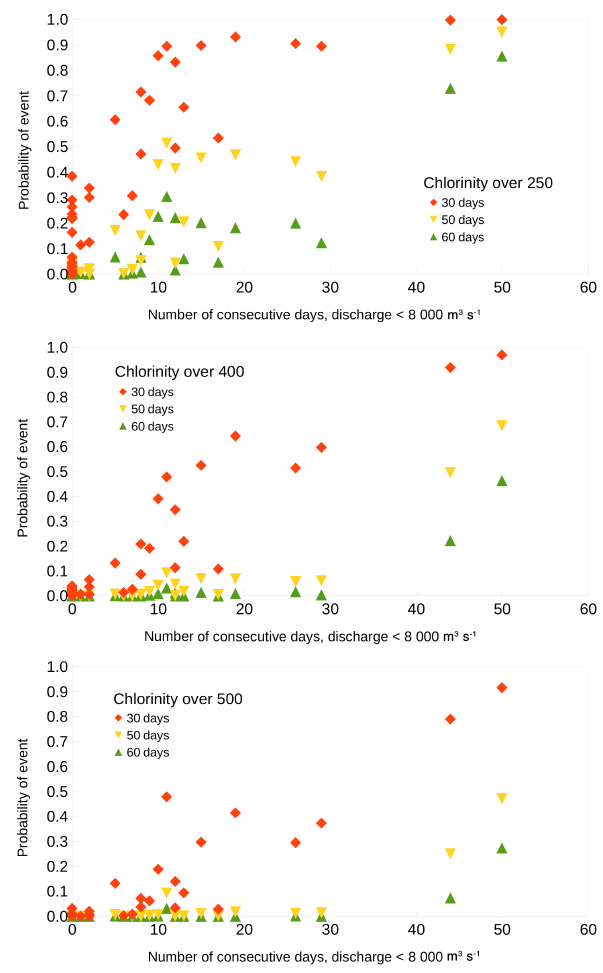
Table 4. Probability of intrusions of ≥ 250mgL − 1 under